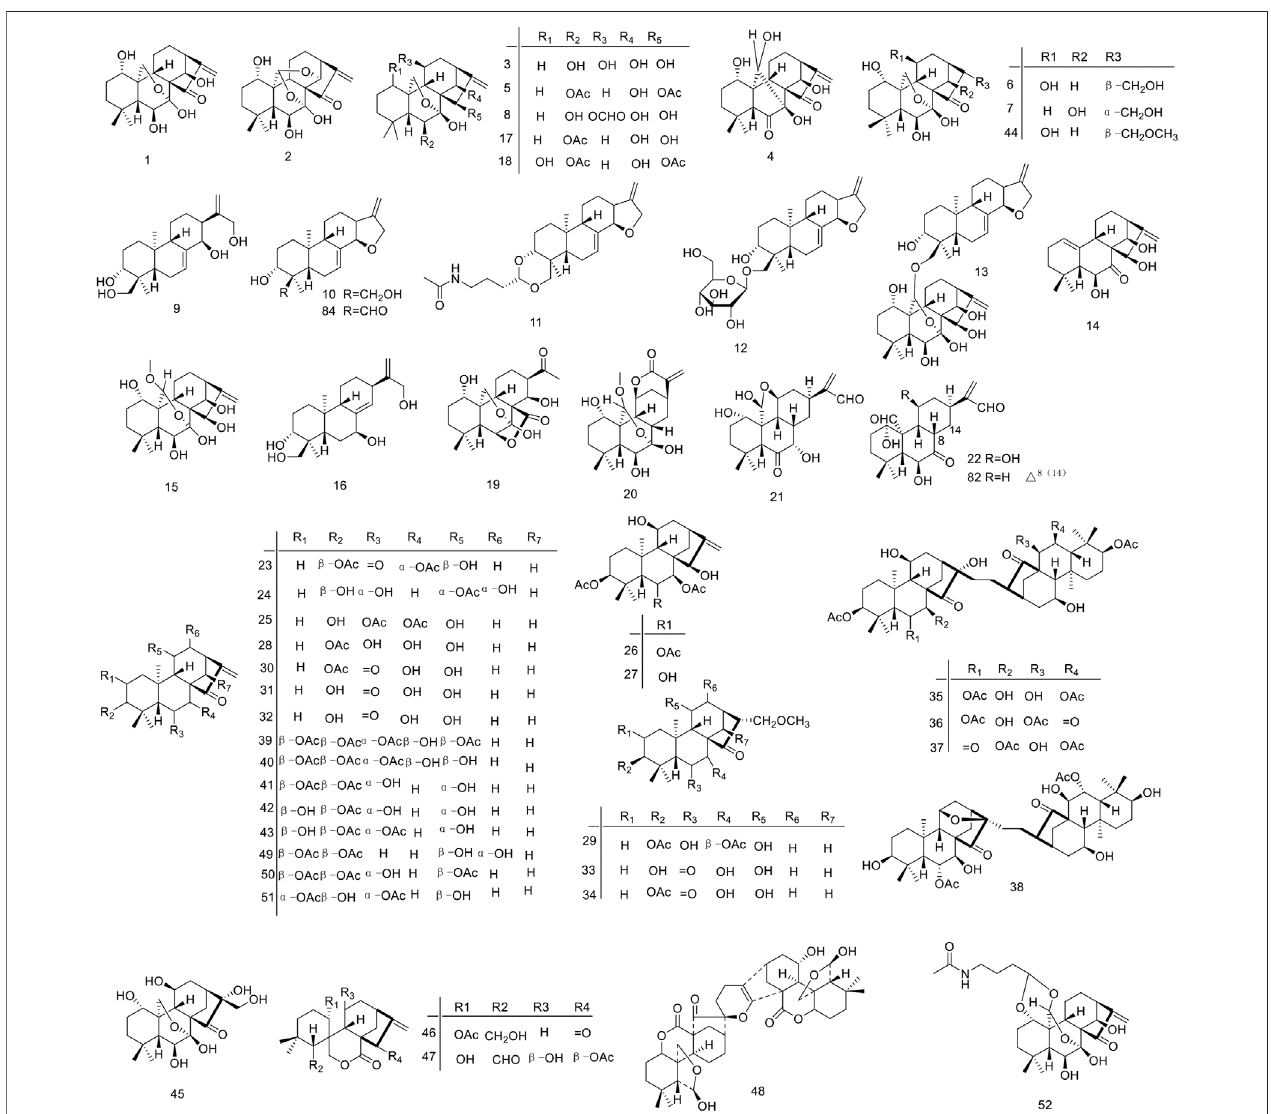
FIGURE 3 | The chemical structure of compounds from I. rubescens